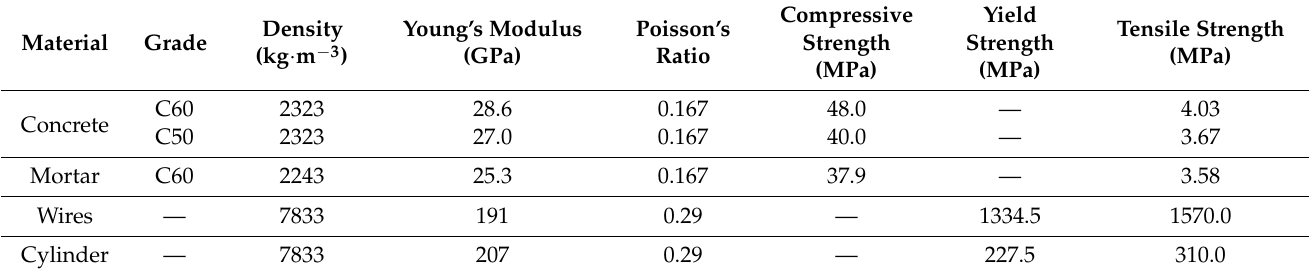
Table 2. Material properties of